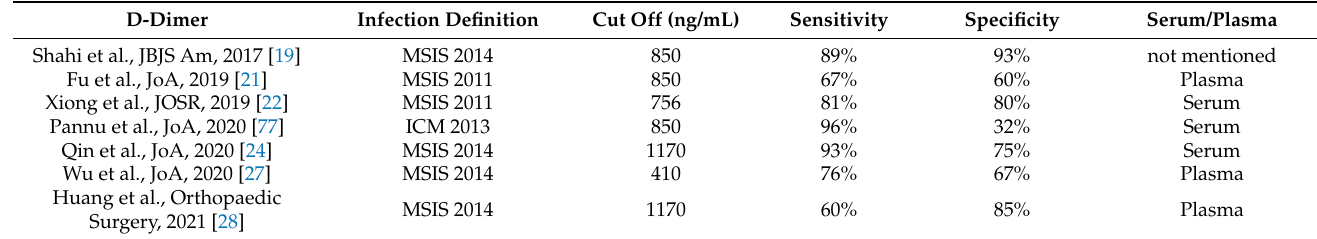
Table 5. Comparison of the literature regarding plasma/serum D-dimer n in the diagnosis of periprosthetic joint infection. D-Dimer Infection